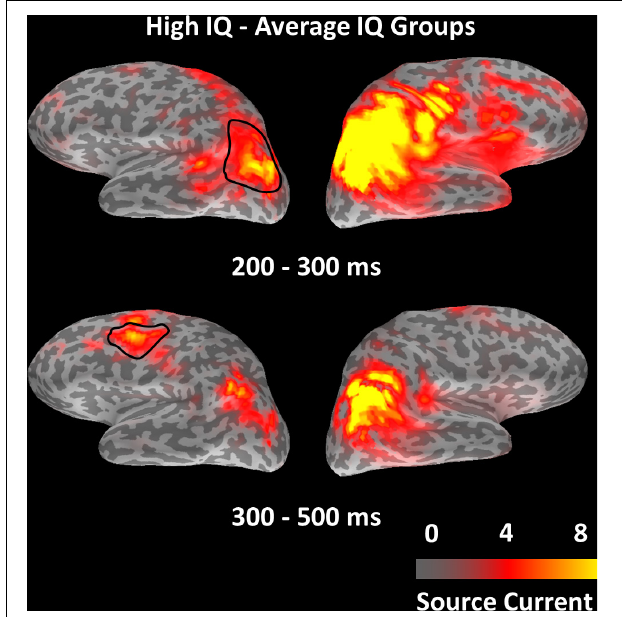
FIGURE 5 | Distribution of test statistic values for the contrast between IQ groups (high-IQ – average-IQ) from the whole-brain non-parametric cluster-level test for spatio-temporal data, displayed for the two windows of 200–300 and 300–500 ms, respectively. The highlighted left-hemispheric parcellations indicate ROIs in which higher source amplitude levels in the high-IQ group were associated with better task performance, in contrast to the average-IQ group (cf. correlation analyses of Figure 4